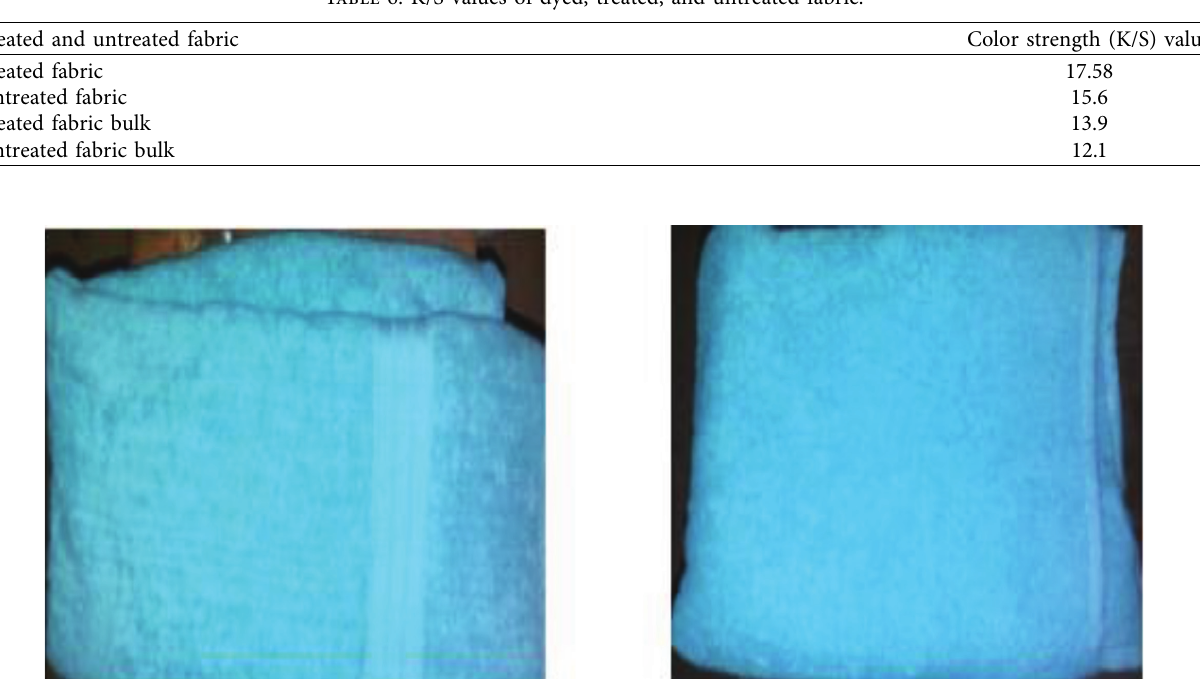
Figure 7: Difference between fabrics: (a) before biosingeing, light and uneven shade; (b) after biosingeing, a deep and uniform